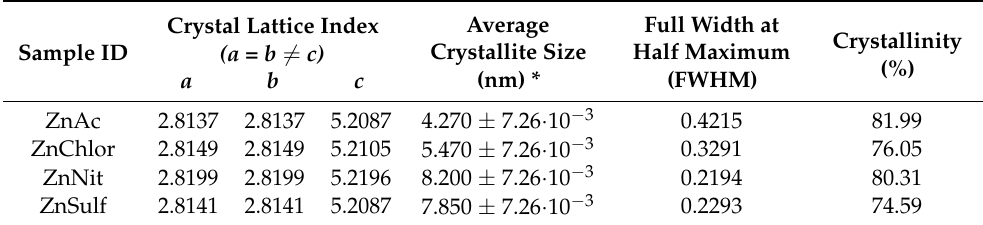
Table 1. Crystal lattice indices, average crystallite size, FWHM and crystallinity of the produced ZnO powders.